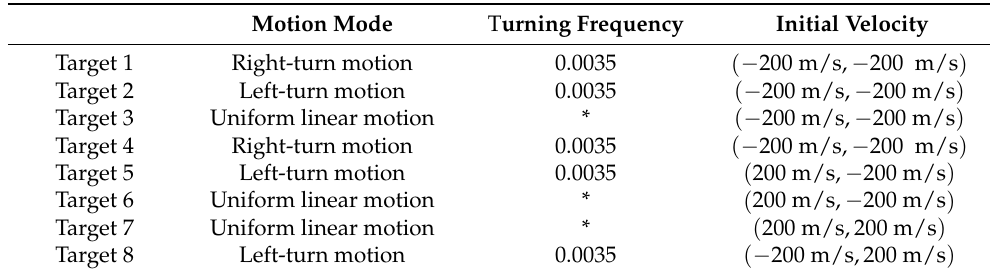
Table 1. Target motion